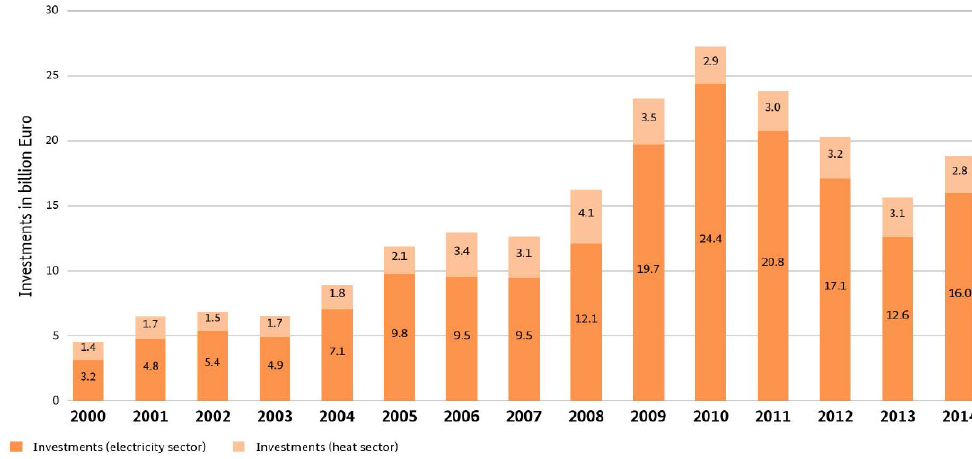
Figure 4. Development of investments in construction of renewable energy installations in Germany [20].